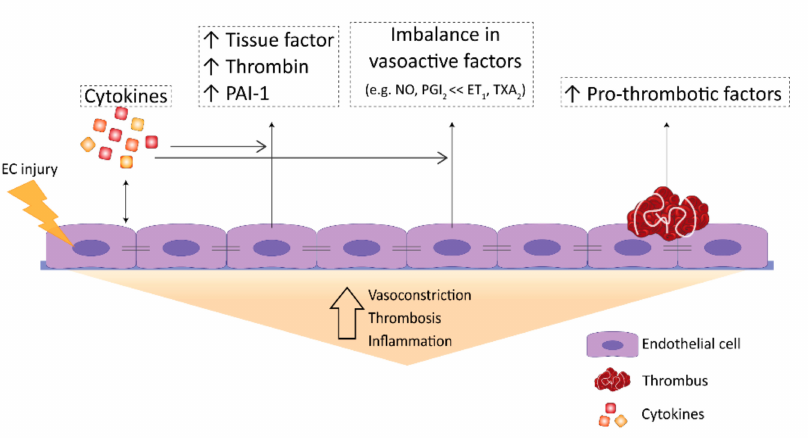
Figure 3. Endothelial dysfunction in PAH. PAH is characterized by endothelial dysfunction that causes an imbalance in the production of several endothelial-specific factors. The endothelium presents a pro-inflammatory phenotype with an increased expression of cytokines, a pro-thrombotic surface due to changes in the expression of clotting factors (e.g., TF) and increased expression of pro- thrombotic factors, and an imbalanced production of vasoactive factors that promote vasoconstriction. Upon endothelial cell injury, pulmonary artery- endothelial cells (PAECs) become dysfunctional and alter their secretion of cytokines and other factors that regulate coagulation, thrombosis, and vascular tone. A failure of PAECs in maintaining vessel homeostasis promotes vasoconstriction, thrombosis and inflammation that initiate PAH disease